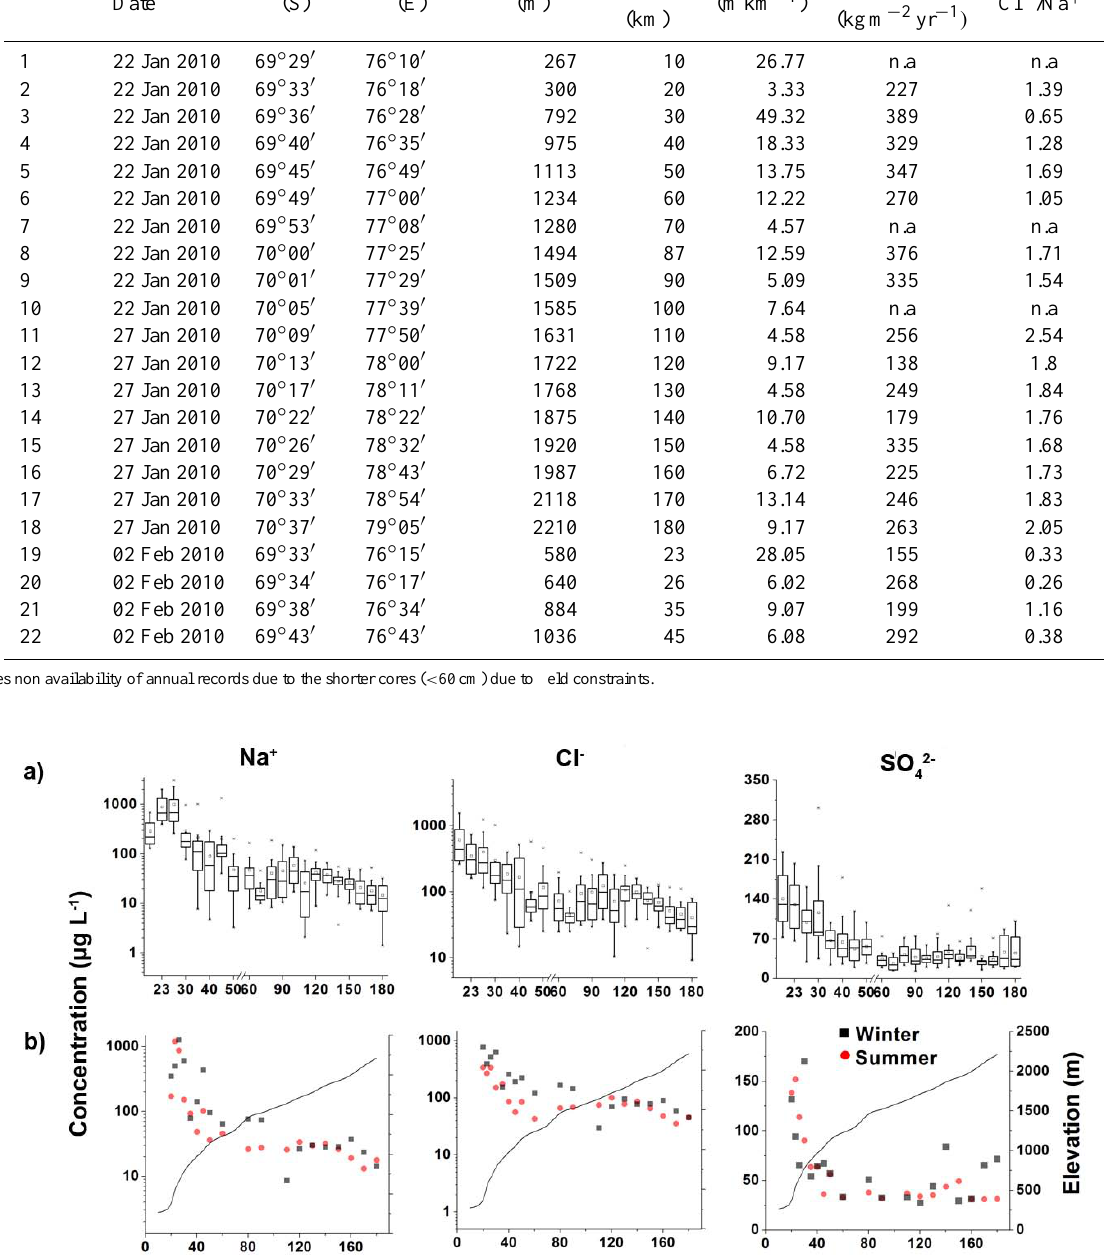
Table 1. Details of sampling parameters along with slope, accumulation rates and annual Cl − /Na + values. Sampling Latitude Longitude